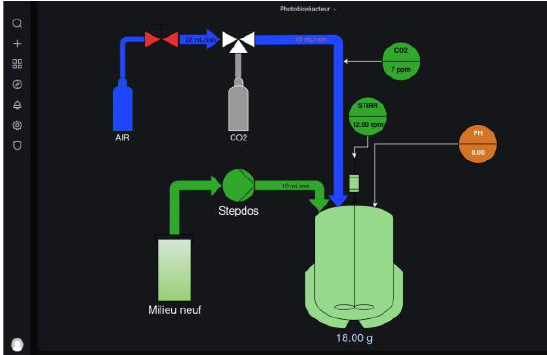
Fig. 8. SCADA on Grafana